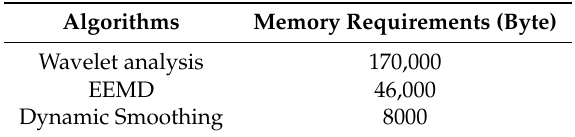
Table 8. Quantitative comparisons of space complexity with N =